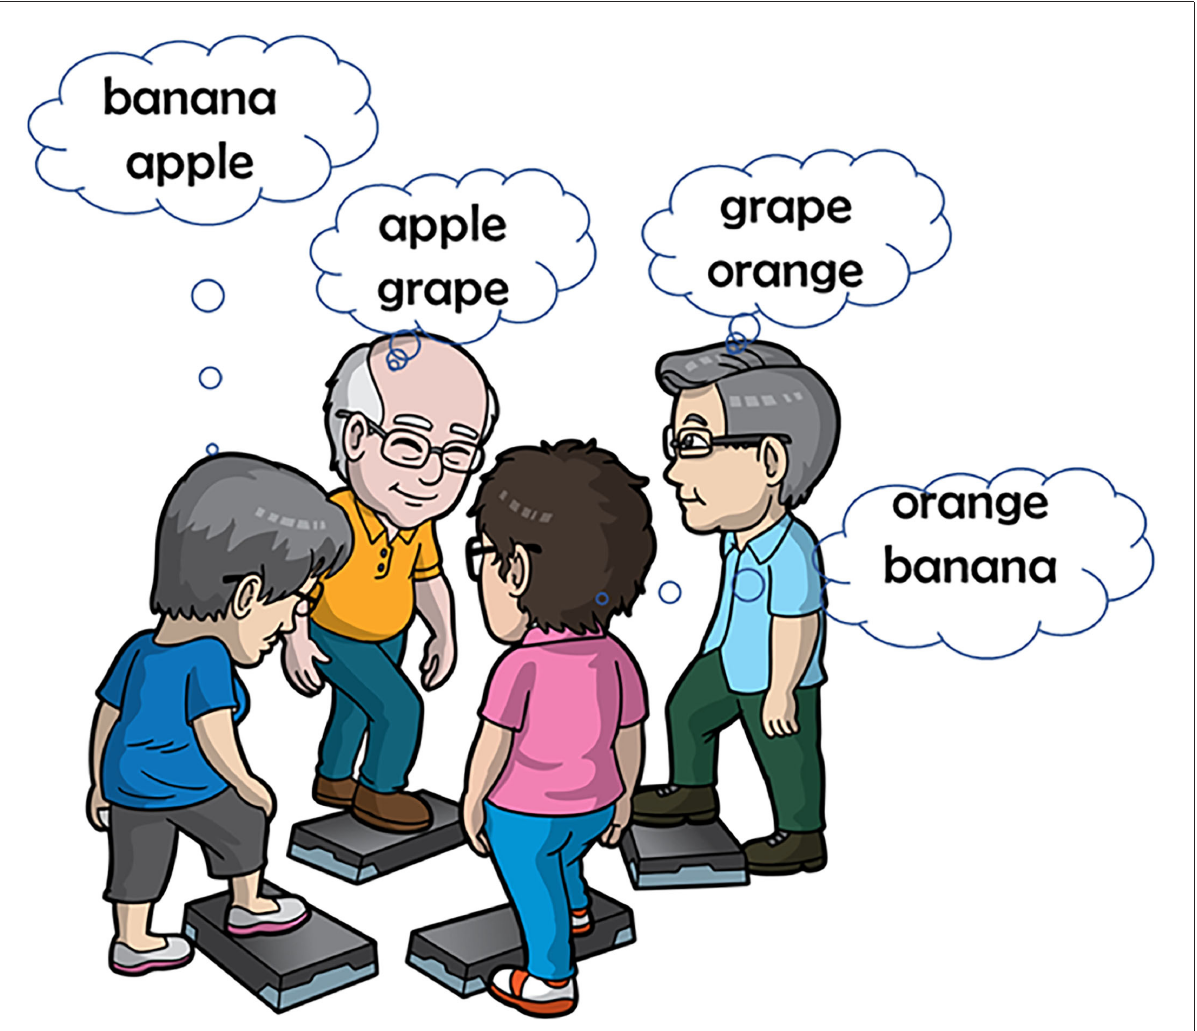
FIGURE1 Example of a dual task exercise within the HAPPY program. Participants have to remember one and think of name of another fruit while doing stepping